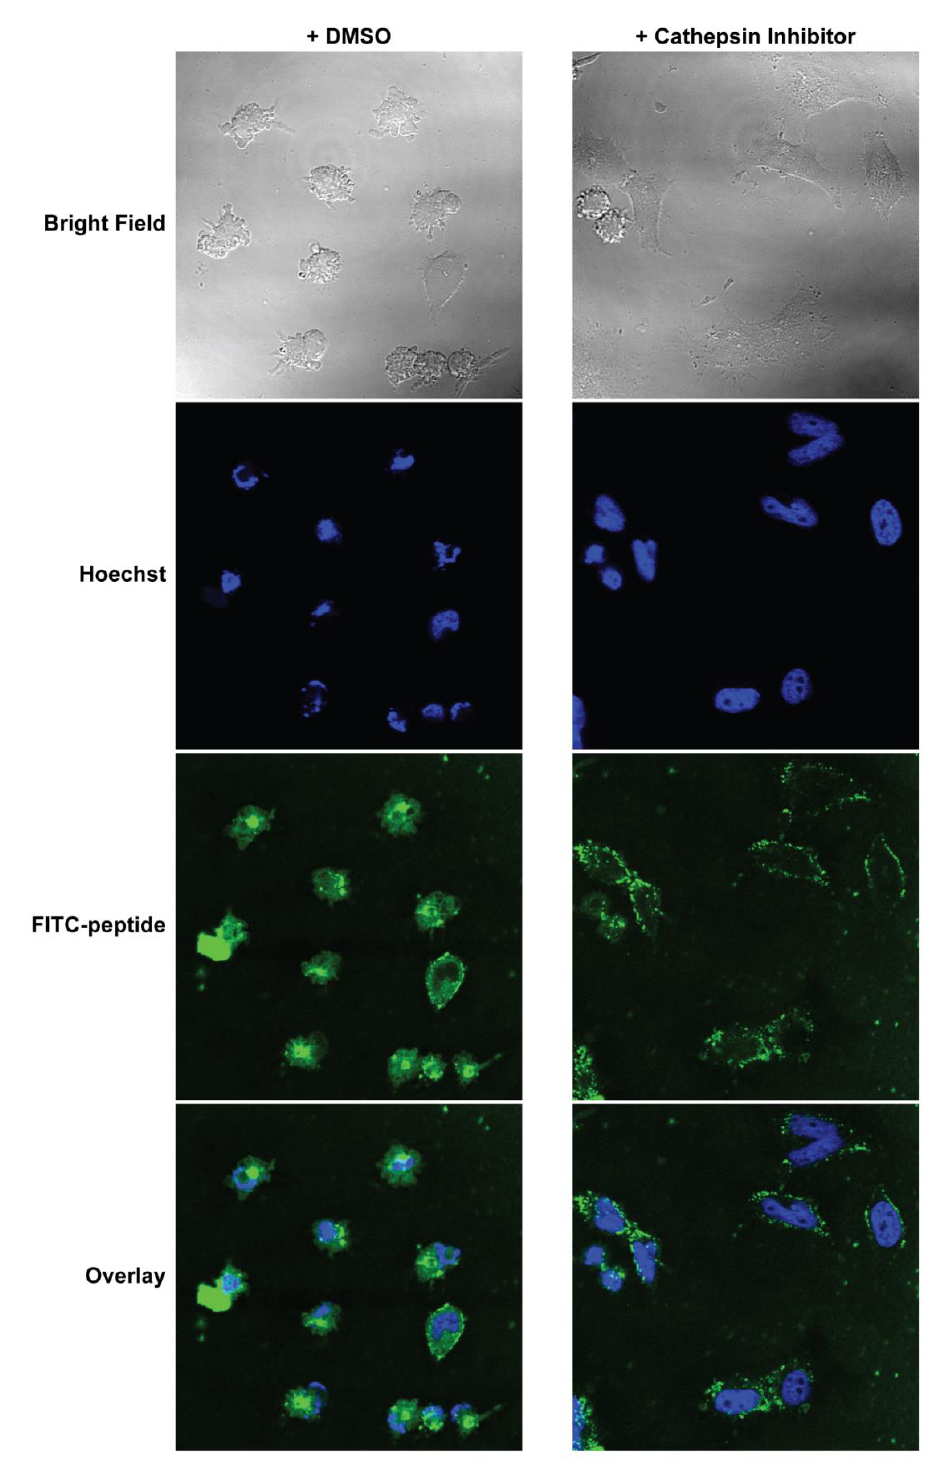
Figure 5. Cathepsin inhibition inhibits cellular uptake and therapeutic function of BIM A,cath,K PA 2 . Mouse embryonic fibroblasts (MEFs) were pre-incubated with either 5 µ M CA-074Me or 0.1% ( v / v ) DMSO control in complete media for 1 h. The cells were then washed and treated with 10 µ M FITC-BIM A,cath,K PA 2 for 2 h before washing, fixation, staining with Hoechst, and confocal imaging. In the DMSO control, the FITC-BIM A signal was located di ff usely throughout the MEFs. Their nuclei appeared fragmented, and their cellular membranes appeared blebbed, consistent with secondary signs of apoptosis. MEFs pre-treated with CA-074Me showed FITC-BIM A localized to the cell membrane and appeared otherwise morphologically normal.